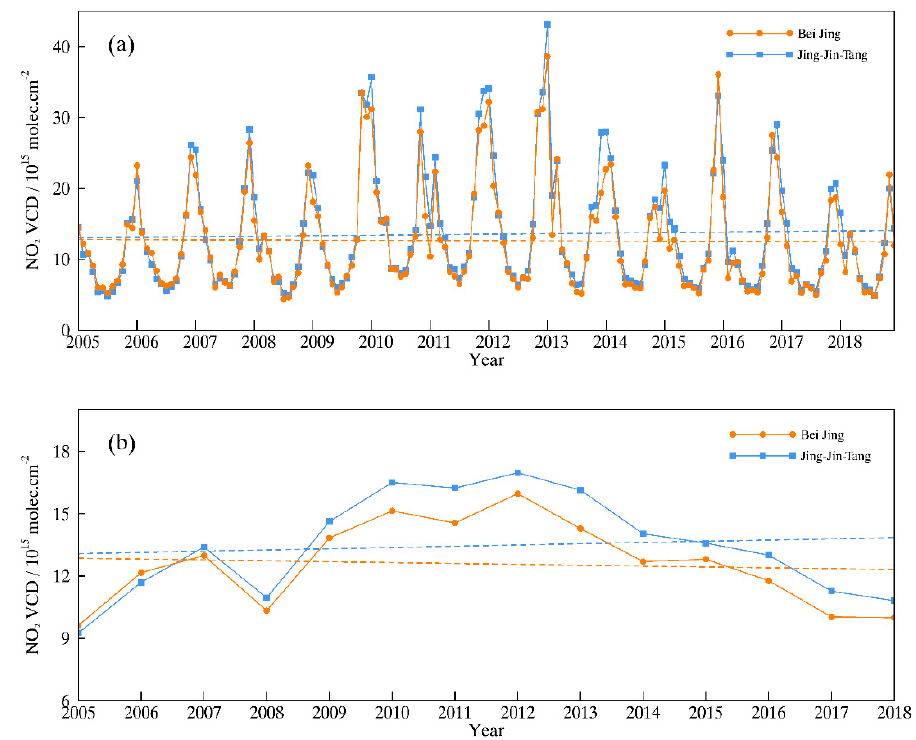
Figure 6. ( a ) Monthly variations in the tropospheric NO 2 VCD in Beijing and Jing–Jin–Tang from January 2005 to December 2018 (unit: 10 15 molec cm − 2 ); ( b ) Yearly averaged variations in tropospheric NO 2 VCD in Beijing and Jing–Jin–Tang from 2005 to 2018 (unit: 10 15 molec cm − 2 ).